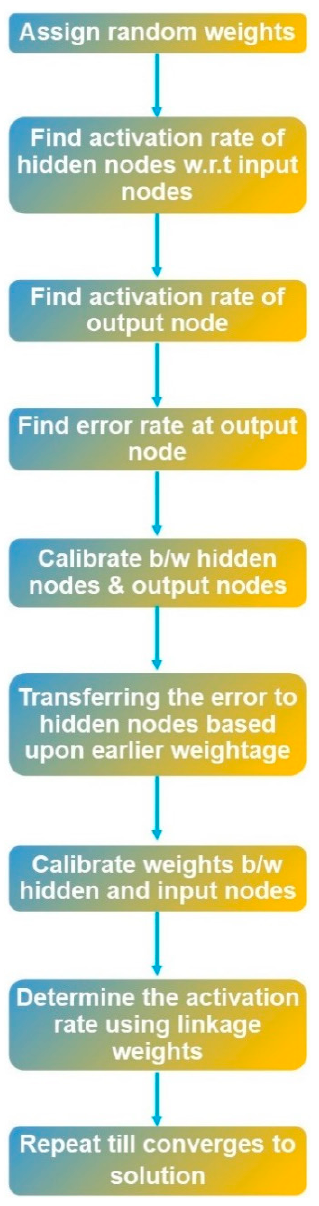
Figure 13. Flow diagram of the ANN classifier.